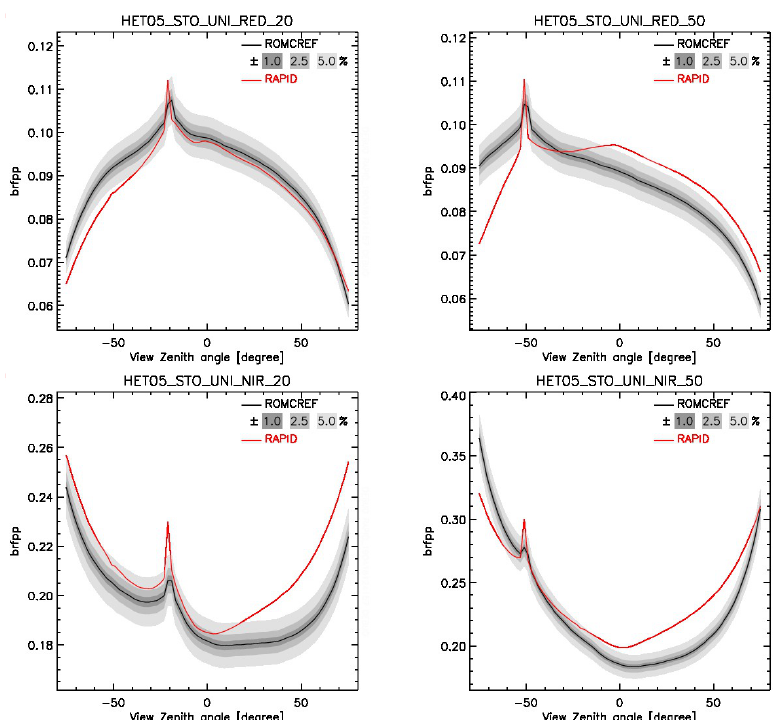
Figure 13. Comparisons of HET05 BRF results in the principal plane (brfpp) with the reference data from the RAMI online checker (ROMCREF).